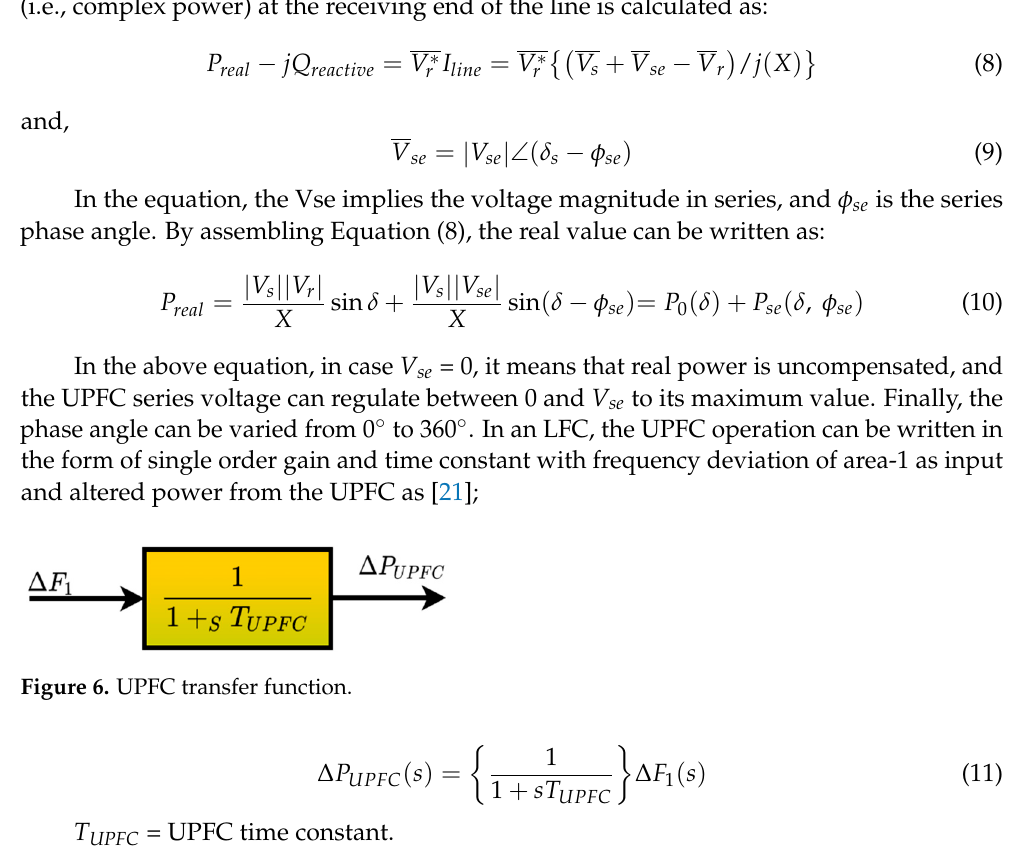
Figure 6. UPFC transfer function.